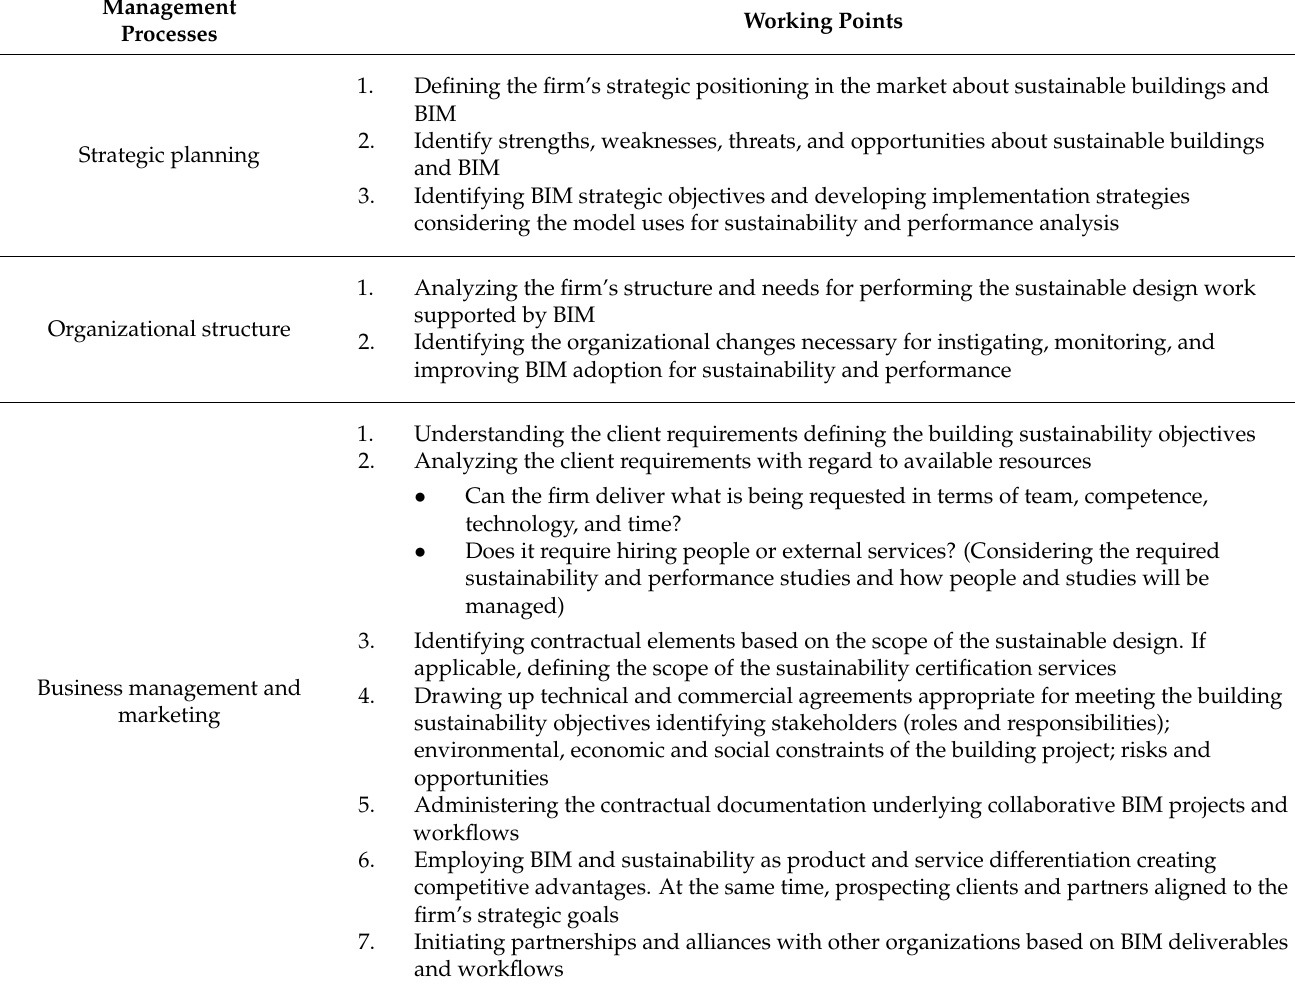
Table 4. Management guidelines for sustainability and BIM (based on ref.